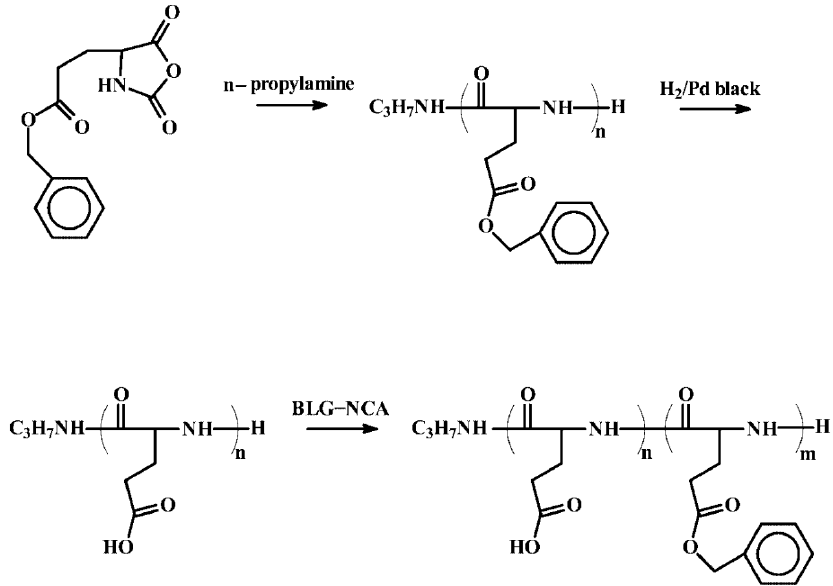
Figure 26. Synthesis of poly[( γ -benzyl- L -glutamate)- b -( L -glutamic acid)] proposed by Higashi et al.